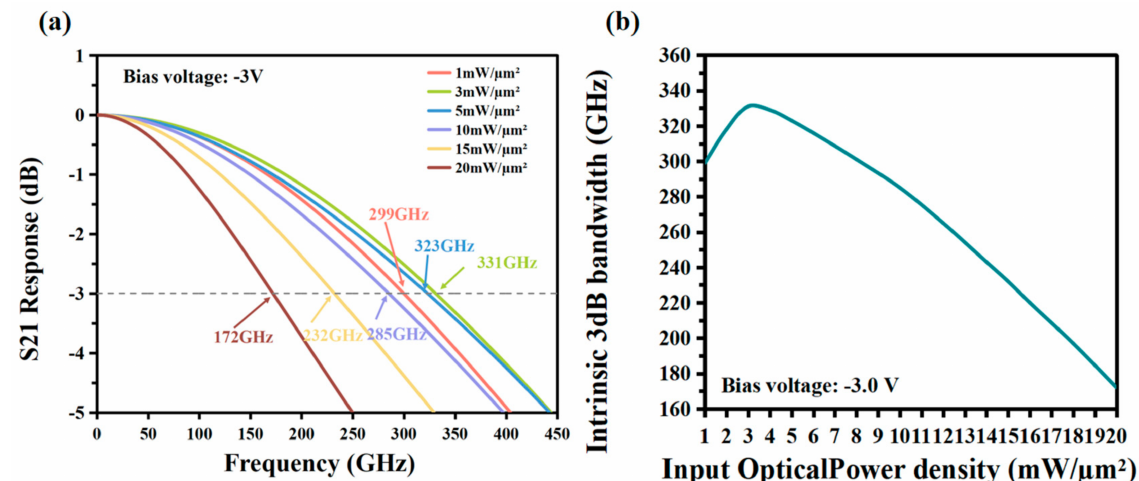
Figure 4. Simulated results use APSYS . ( a ) small signal S21 response curves of our baseline MUTC- PD design under different input optical power densities. ( b ) The 3 dB bandwidth plotted vs. optical power density.